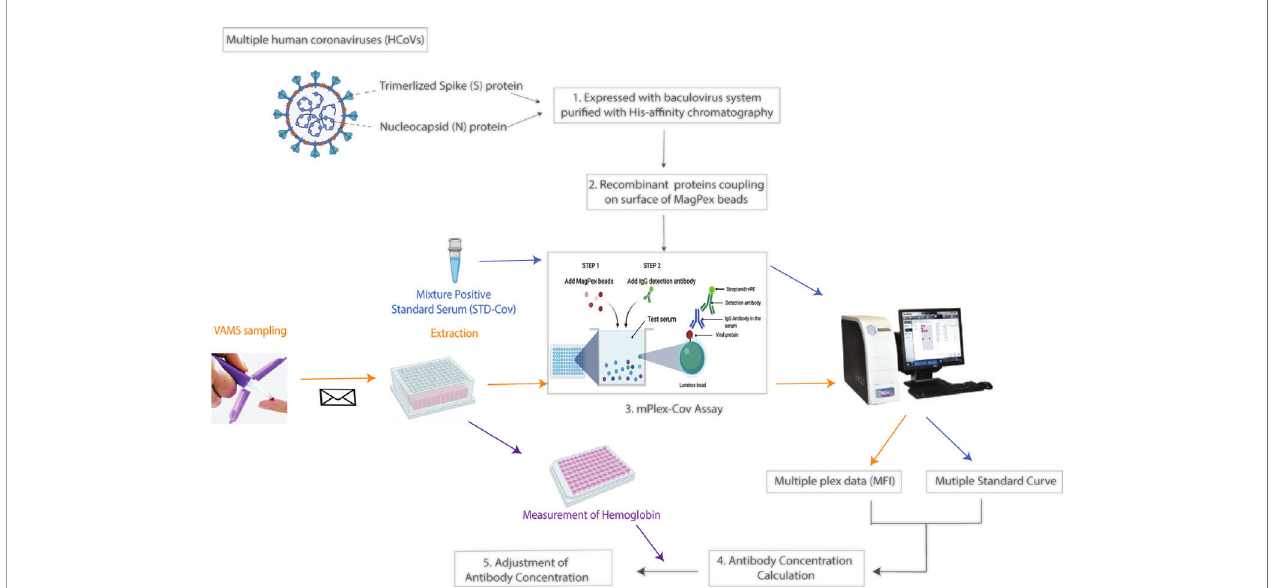
FIGURE 1 | The study work fl ow. 1. Expression of recombinant spike (S) proteins and nucleocapsid (N) of Human coronavirus (HCoVs) listed in Table 1 with baculovirus expression system. The proteins were then puri fi ed with His-af fi nity chromatography. 2. Coupling the individual recombinant proteins of HCoVs onto fl uorescence-coded Luminex beads. 3. Establish the multiple plex assay, mPlex-Cov. 4. Calculation of HCoV strain-speci fi c antibody concentration with the standard curve of each individual virus strain. 5. Adjustment of antibody concentration in the blood sample by hemoglobin to correct for the actual serum volume. (Figure was generated with